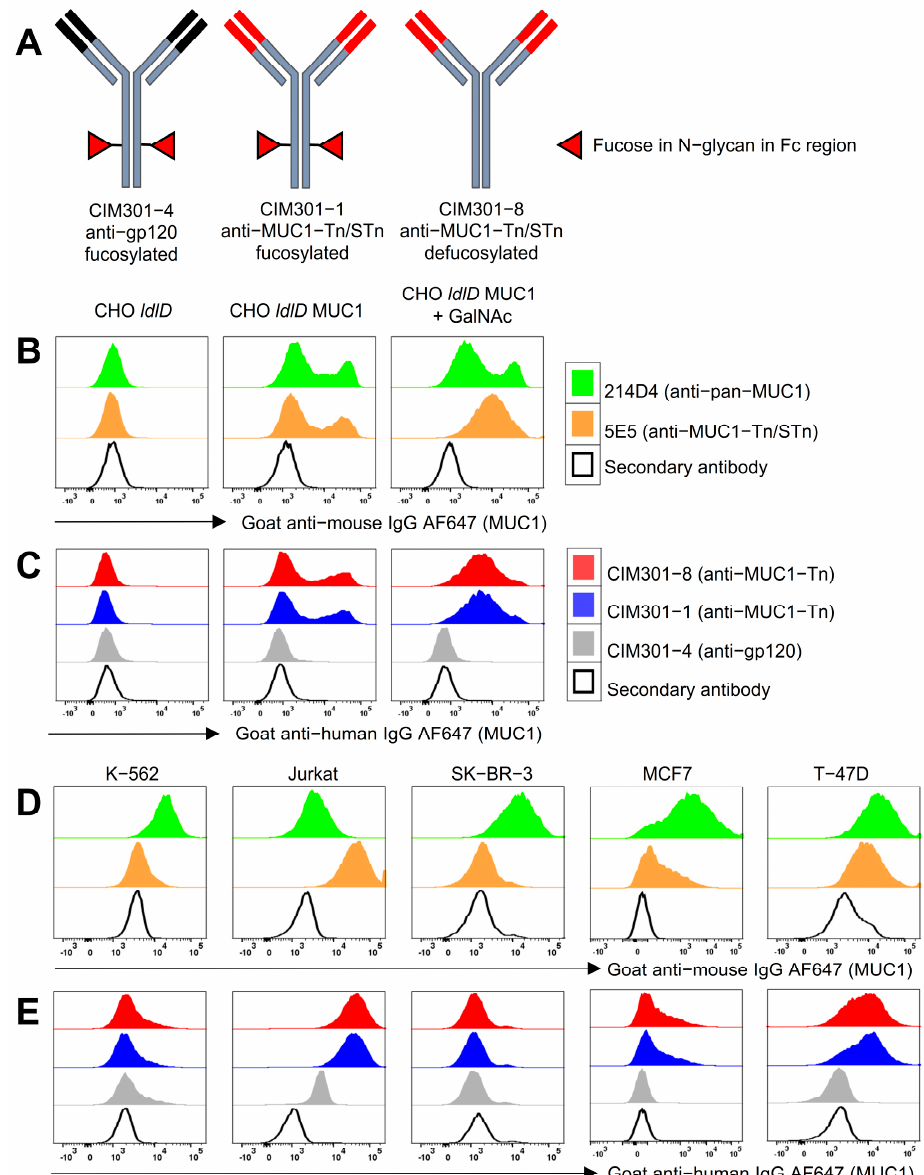
Figure 1. Fully humanized anti-MUC1 antibodies specifically recognize tumor-associated MUC1 epitopes. ( A ) Illustration outlining the design of the antibodies recognizing MUC1 or an irrelevant epitope (control) used in this study. Red triangles indicate glycosylation with fucose of the N-glycans in the antibody Fc tail. ( B ) Overlay histograms of MUC1 expression on CHO cell lines detected using murine antibodies. CHO cells expressed no MUC1 (CHO ldlD ), glycosylated MUC1 (CHO ldlD MUC1), or MUC1-Tn/STn with tumor-associated glyco-epitopes (CHO ldlD MUC1 + GalNAc). ( C ) Overlay histograms of MUC1 expression on CHO cell lines detected by humanized antibodies. CHO cell lines as described in ( B ). ( D ) Expression levels of MUC1 or under-glycosylated MUC1 on cancer cell lines detected using 214D4 and 5E5 murine antibodies, respectively. ( E ) Histograms showing binding of humanized anti-MUC1 antibodies to various cancer cell lines.